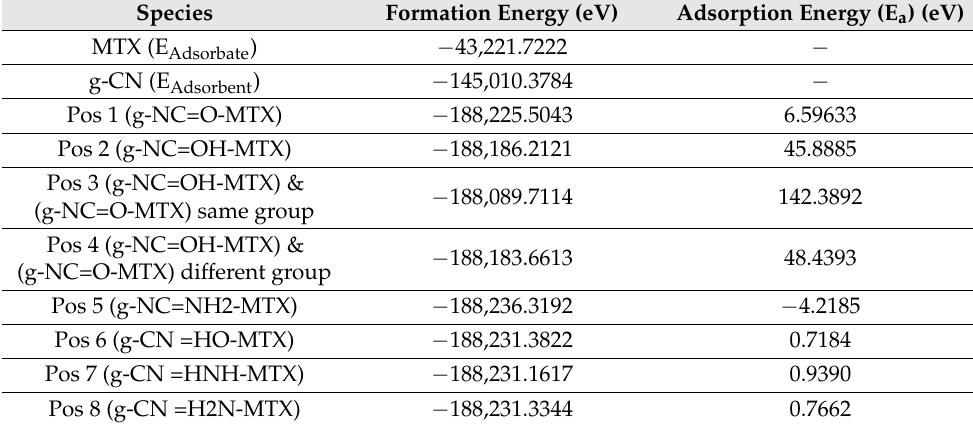
Table 2. Formation and adsorption energy for each position via DMOL3